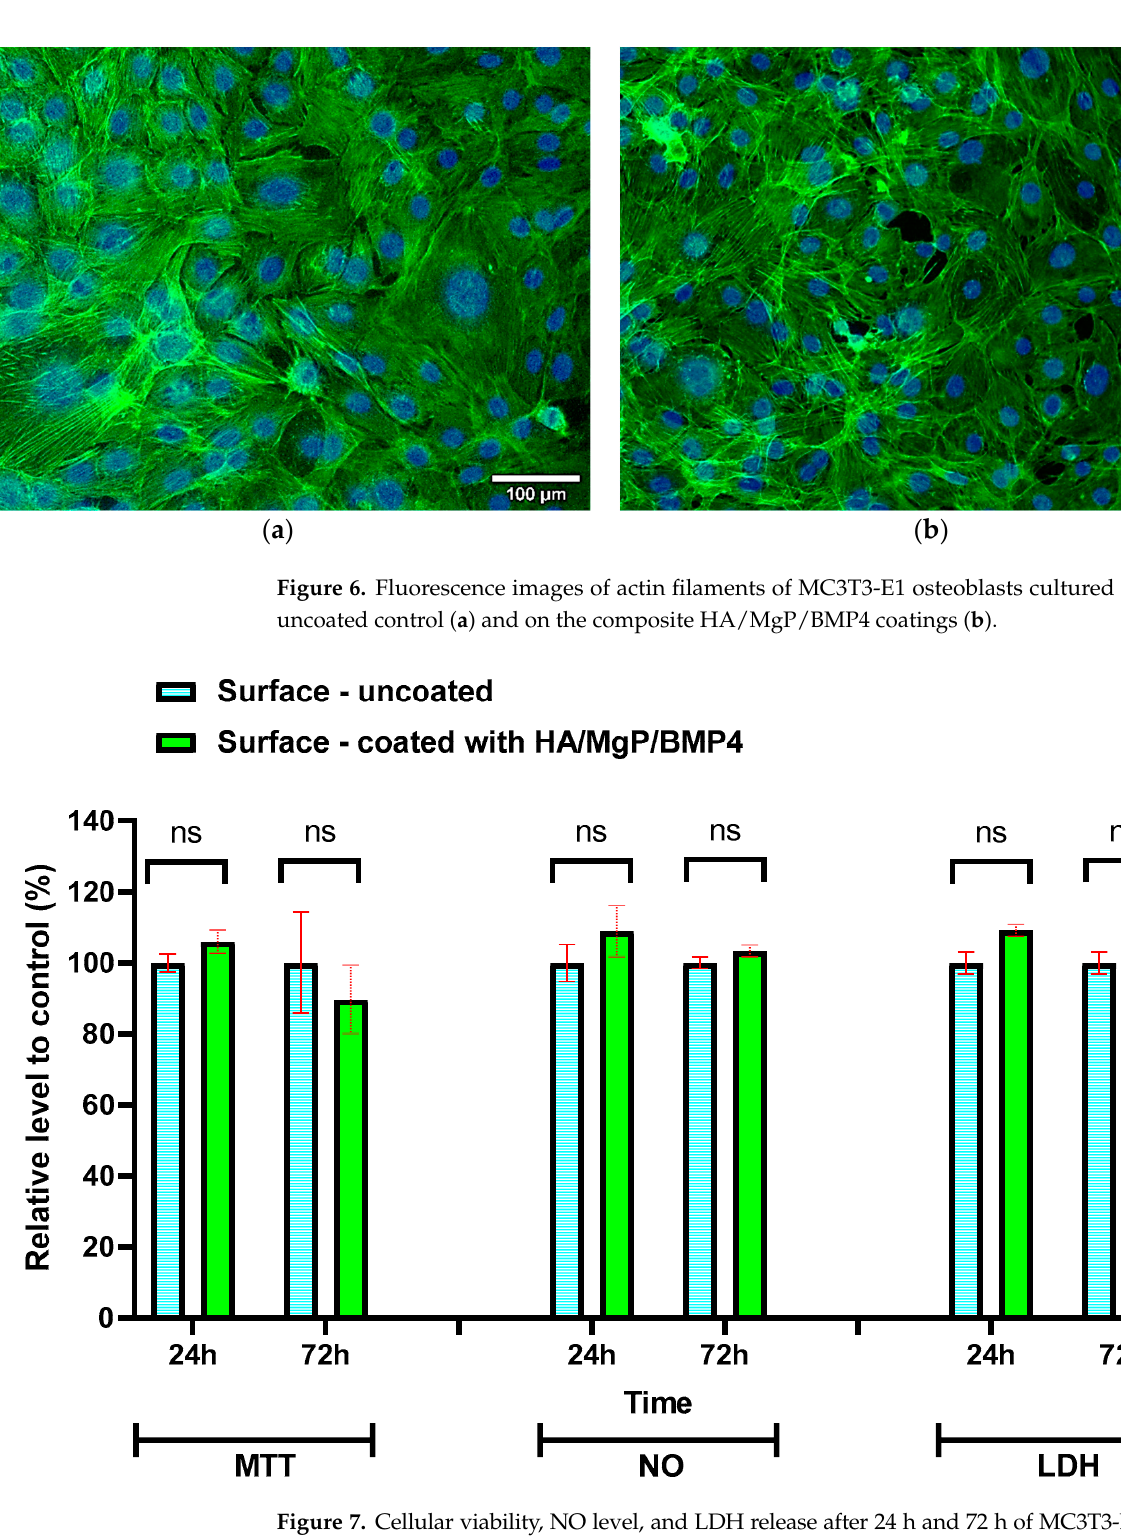
10 of 17 Figure 5. SEM images at various magnifications ( a —10,000×, b —20,000×, c —100,000×, d —200,000×) and cross-section ( e ) for the HA/MgP/BMP4 coatings. 3.3. Cytocompatibility Evaluation on Osteoblasts In this study, the bioactive coatings were further studied for their cytocompatibility and antimicrobial properties. The coatings’ bioactivity was achieved by adding different types of bioactive molecules, i.e., growth factors that could considerably enhance the formation of the natural bone, a key stage in the tissue-healing process, and one antibiotic that could prevent microbial colonization and the occurrence of periprosthetic infections. The growth factor molecule used in our study is represented by BMP4 (SigmAldrich, Saint Louis, MO, US), which is naturally located within the interstitial tissue of the bone, stimulating bone regeneration [61–63]. BMPs have been either immobilized at the surface of the orthopedic implant or loaded in implant coatings, this last approach exhibiting the advantages of an increased incorporation rate and bioactivity, as well as a slow, localized release. BMP4 activity could be assessed in vitro by determining the morphology, attachment, proliferation, and differentiation of different types of cells on bioactive implant surfaces. In our study, we tested the interaction between the HA/MgP/BMP4 coatings and the murine osteoblasts belonging to the MC3TE-E1 cell line. Figure 6 depicts the fluorescence microscopy images of the cells grown on the